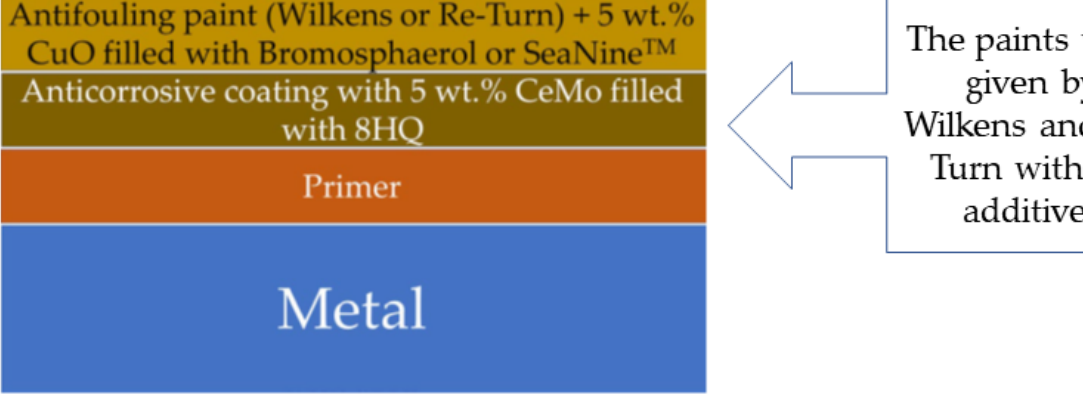
Figure 4. Paint configuration for lab testing and used for real-ship paint testing .